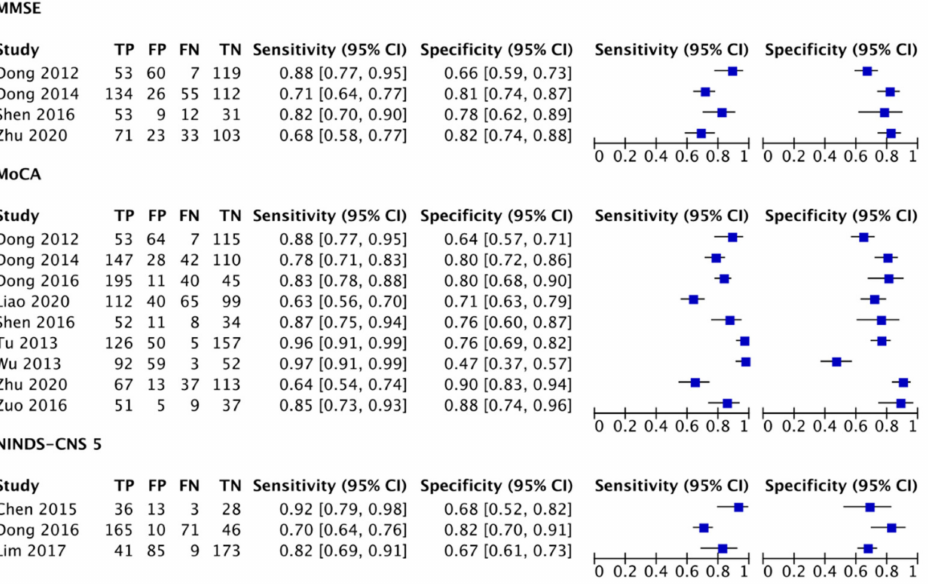
Figure 3. Forest plots depicting the SE and SP of the MMSE, MoCA, and NINDS-CNS 5; MMSE: Mini-Mental State Examination; MoCA: Montreal Cognitive Assessment; NINDS-CNS 5: The National Institute of Neurological Disorders and Stroke–Canadian Stroke Network 5-Minute Protocol; TP: true positive; FP: false positive; FN: false negative; TN: true negative; CI: confidence